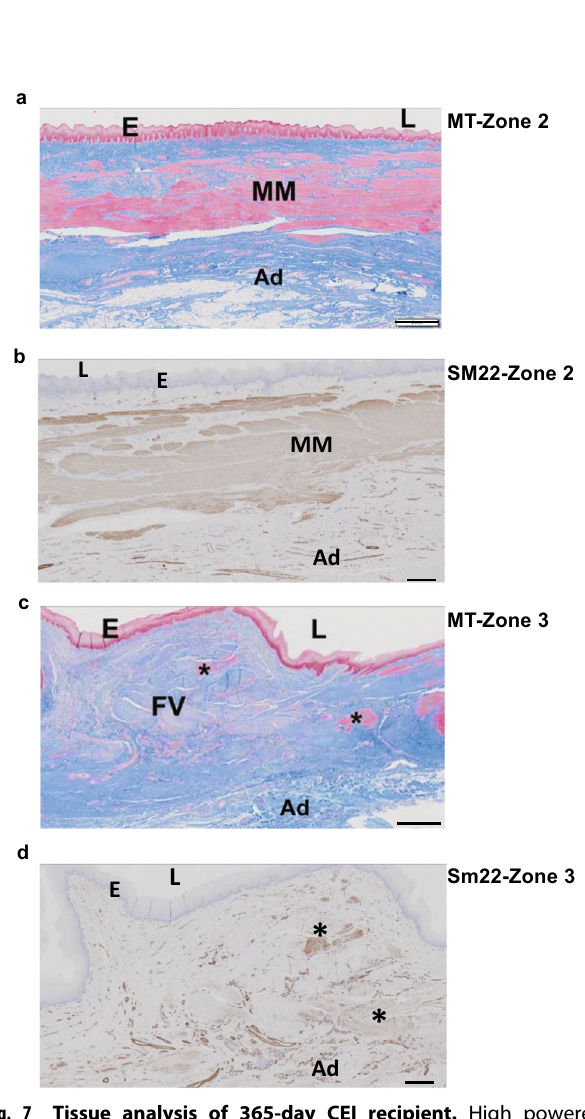
Fig. 7 Tissue analysis of 365-day CEI recipient. High powered microscopic histologic analysis of the 365-day CEI recipient. Panels a – d are high powered images of the CEI implants taken from Zone 2 ( a , b ) and Zone 3 ( c , d ) from the 365-day recipient ( a , c = MT stain; b , d = SM22 stain; E = epithelium; L = lumen; FV = fi brovascular tissue; Ad = adventitia; asterisks indicate areas of muscle cell staining in c , d ). Scale bars = 1 mm in the MT stained slides ( a, c ) and 500 μ m in the SM22 stained slides ( b, d